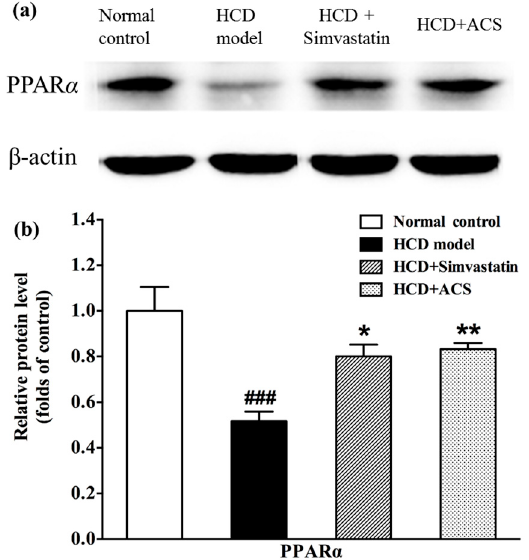
Figure 8. Effects of ACS extract on protein expression of hepatic PPAR α of rats: ( a ) protein expression of PPAR α in the liver of rats was changed by simvastatin and ACS; and ( b ) the protein levels were expressed relative to β -actin. Data are expressed as means ± SEM ( n = 7). One-way ANOVA, Tukey HSD post hoc test. ### p < 0.001 represent significant differences when compared with the Control group. * p < 0.05 and ** p < 0.01 represent significant differences when compared with the HCD group.